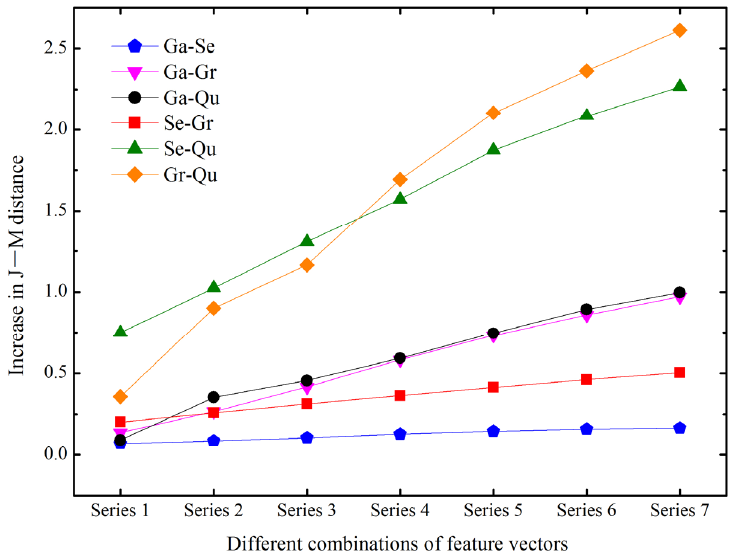
Figure 6. Increases in class separability for seven series compared to results obtained using only spectral vectors. Ga is gabbro, Se is serpentinite, Gr is granite, and Qu is quartzose rock.